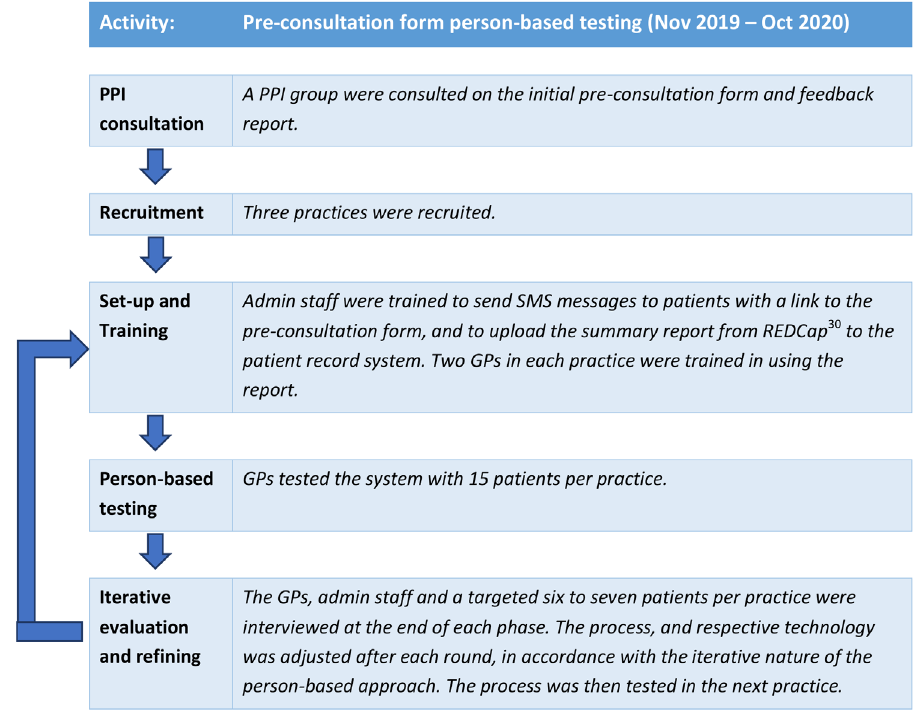
Figure 2. Person-based approach taken to develop the pre-consultation